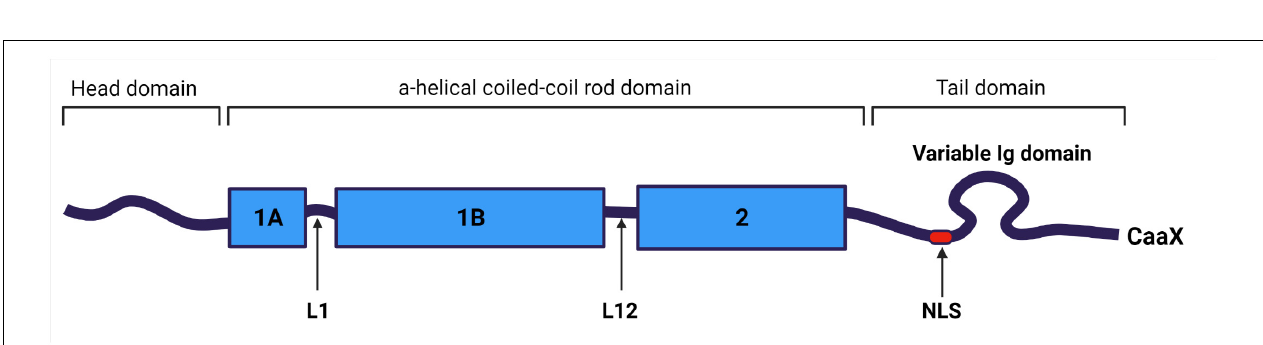
FIGURE 2 | Structural organization of lamin A/C filament. Lamin A/C is an intermediate filament, and contains a central coiled-coil rod domain divided into 1A, 1B, and 2 sub-domains connected via L1 and L12 linkers; a head domain; and a tail domain containing nuclear localization signal (NLS), Ig-like domain and carboxyterminal CaaX box (apart of lamin C), where C is cysteine, a – aliphatic amino acid, and X can be any amino acid. Created with BioRender.com.